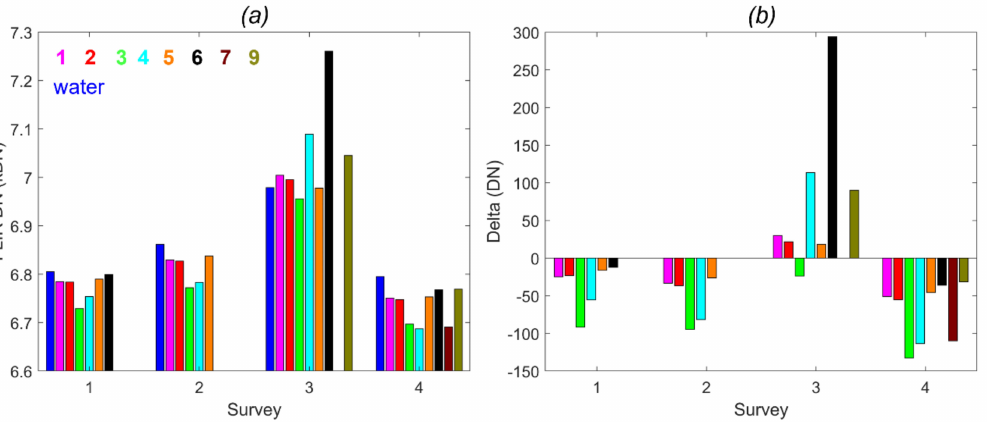
Figure 5. ( a ) FLIR signal (kDN) for all imaged surfaces during all UAV surveys, except the aluminum foil reference (flatfield-corrected with sigma = 30), and ( b ) delta (DN) using uncorrected images. Legends indicate: 1-PET S, 2-PET L, 3-EPS white, 4-EPS blue, 5-HDPE, 6-bin bag, 7-tarpaulin, and 9-wood. Error bars were too small to